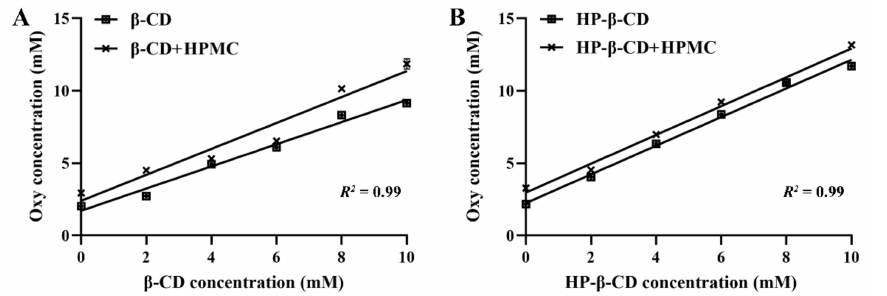
Figure 2. Phase solubility diagrams of Oxy and CD with or without the presence of 1 mg/mL HPMC solutions at 20 ◦ C ( n = 3, if no error bars are displayed, errors were smaller than symbols). ( A ) β -CD; ( B ) HP– β